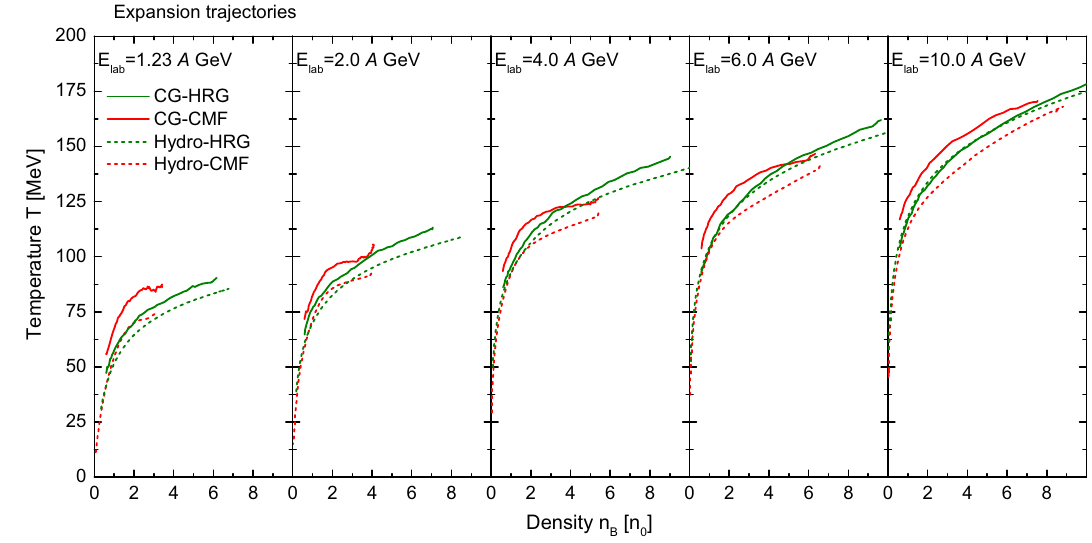
Fig. 5 Expansion trajectories (along the time evolution in the central cell) in the temperature-baryons density plane for central Au+Au reac- tions at E lab = 1 . 23 , 2 . 0 , 4 . 0 , 6 . 0 , 10 . 0 A GeV (from left to right). The full lines show the results of coarse grained UrQMD simulations and the dashed line shows the results for one-fluid (3+1) dimensional hydrody-